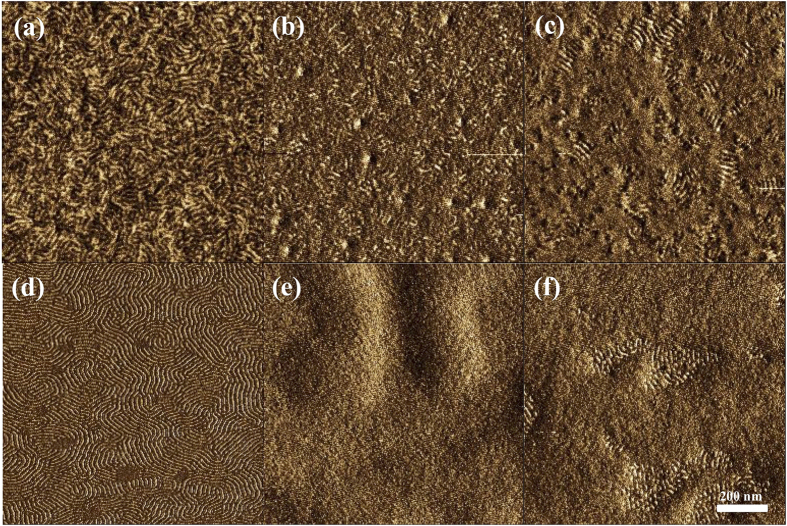
AFM phase images of a 32-nm-thick (=2.0L0) PS100-b-PMHxOHS25 film cast from different solvents(a–c) before annealing and (d–f) after annealing at 130 °C for 1 min. (a,d) Cast from a PGMEA solution. (b,e) Cast from a toluene solution. (c,f) Cast from a chloroform solution with a PMMA-r-PMA film.